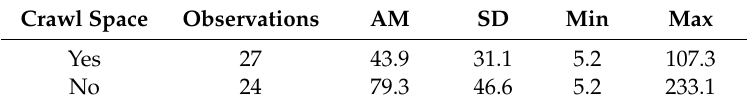
Table 4. Mean Indoor Radon Concentration [Bq / m 3 ] Level by Navajo Nation Agency. Crawl Space Observations AM SD